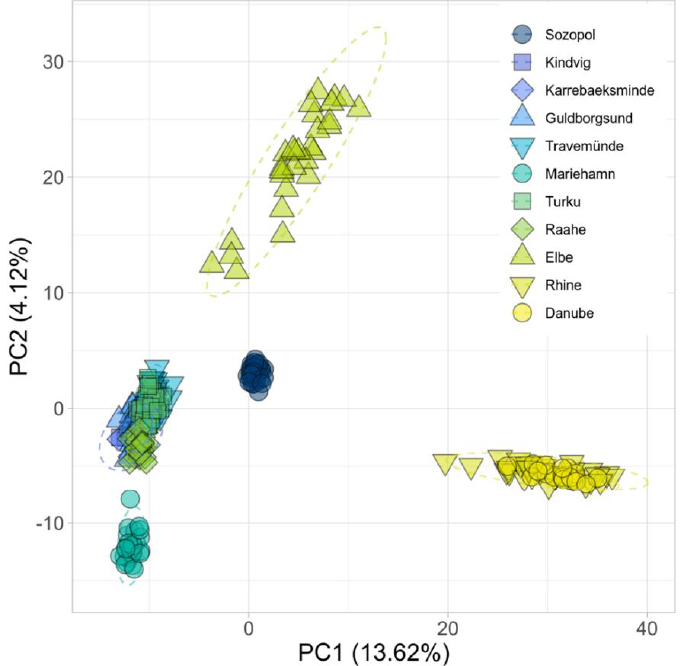
Figure 6. First ( x -axis) and second ( y -axis) component of a principal component analysis (PCA) on the genetic relationship of 264 round gobies ( Neogobius melanostomus ) calculated from 13,847 SNPs. The first component explains 13.62% of the total variation and the second explains 4.122%. Each point represents one individual, colours represent sampling origin and shape is used for better dis- tinction between sites. Dashed ellipses show 95% confidence intervals for multivariate normal